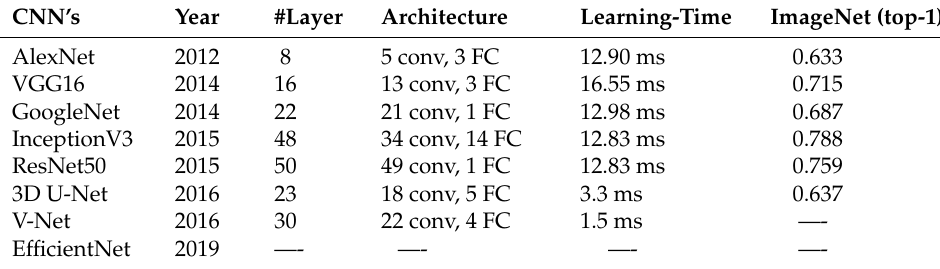
Table 2. Overview of comparison between CNN’s